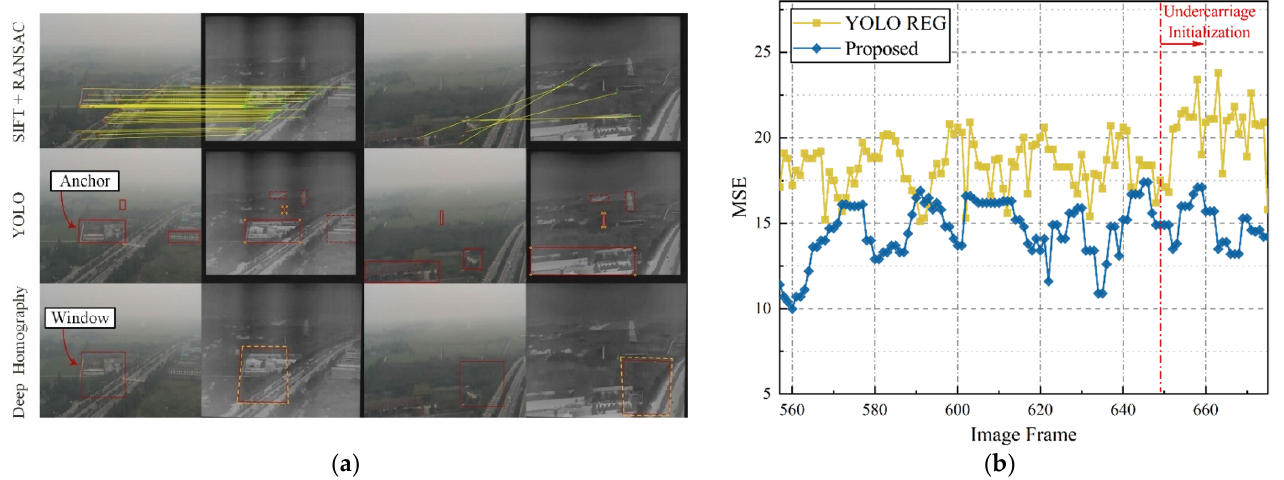
Figure 6. Registration results. ( a ) Registration in different stages; ( b ) real-time estimation errors.